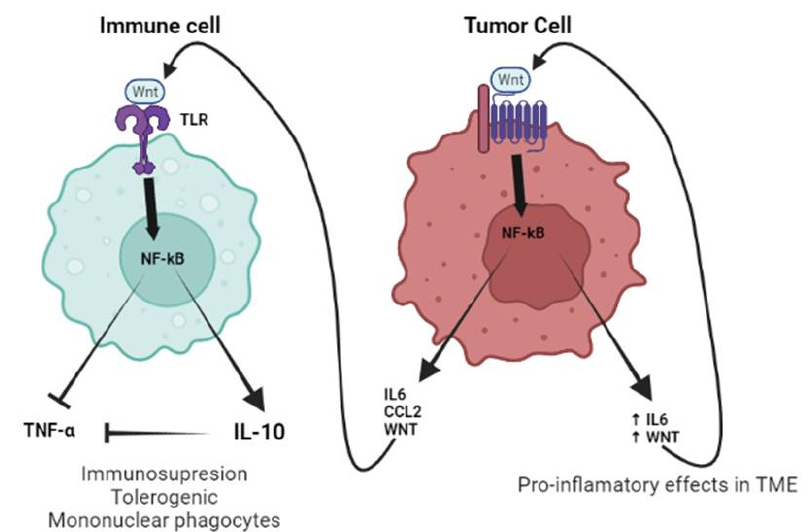
Figure 4. Interaction between tumor-derived WNT and immune cells. Increased production of WNT by tumor cells (right part of the figure) stimulates an autocrine pathway that promotes the secretion of proinflammatory cytokines (IL-6) and chemokines (MCP-1). Both cytokines and WNT are main- tained at a high level of expression by a self-feeding loop. Chemokines are critical for populating the tumor microenvironment (TME) with immune cells. The different cytokines induced by WNT, together with the WNT ligand itself, would stimulate other cells in the TME, such as tumor-associ- ated fibroblasts or endothelial cells that further amplify the effects of WNT. At a later stage, once immune cells are recruited to the TME, WNT begins to play a different role (left part of the figure). In this new scenario, WNT activates a TLR/MyD88/p50 pathway, promoting the synthesis of the anti-inflammatory cytokine IL-10. As a result, WNT induces immunosuppression and the formation of tolerogenic mononuclear phagocytes. Created with BioRender.com (accessed on 21 March 2022).